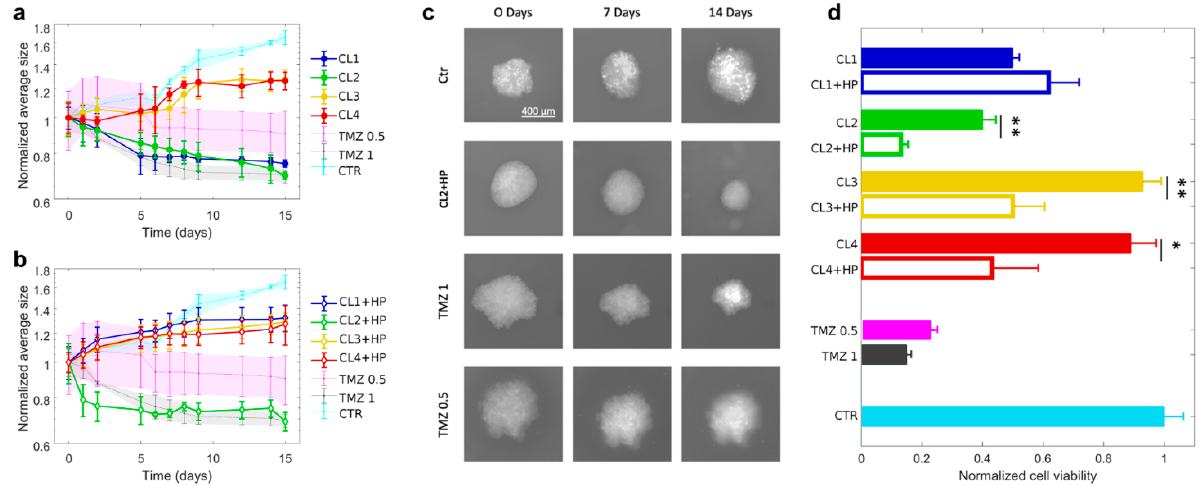
Figure 2. Glioblastoma spheroids treated with TMZ-loaded CLs with and without BC. ( a ) Spheroid growth in time expressed in terms of normalized average size after the treatment with TMZ-loaded CLs and ( b ) TMZ-loaded CLs incubated with human plasma (HP). ( c ) Representative images at 0, 7 and 14 days of glioblastoma spheroids after the treatment with control solution, TMZ-loaded CL2 incubated with human plasma (HP) and free TMZ at two different concentration (0.5 mg/mL and 1 mg/mL). ( d ) Cell viability of spheroids after two weeks of treatment with CLs (filled histograms) and CLs incubated with HP (empty histograms). CL1 (DOTAP/cholesterol), CL2 (DOTAP/DOPE), CL3 (DC Chol/DOPE), CL4 (DC-Chol/cholesterol). Statistical significance was evaluated by student’s test with respect to CLs incubated with HP. ** p < 0.05, * p < 0.001, no asterisk means not